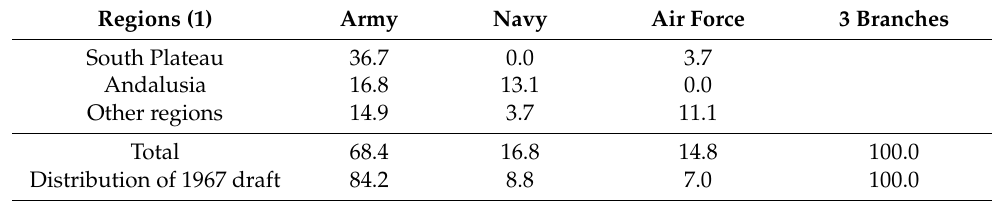
Table 4. Distribution of survey subjects by armed forces branch (in %) Subjects by military branch. Regions (1) Army Navy Air Force 3 Branches South Plateau